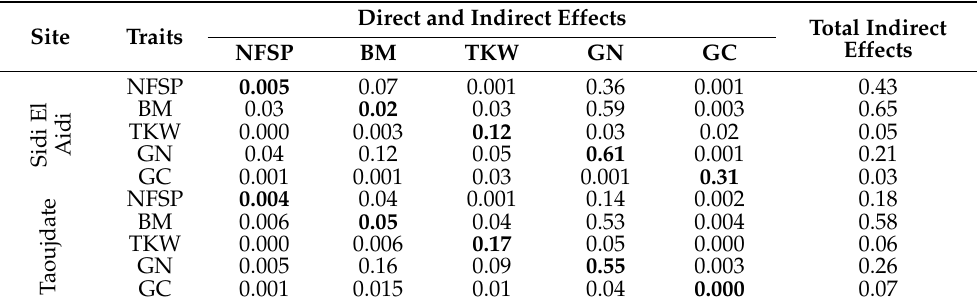
Table 3. Direct and indirect effects of each variable on grain yield under favorable and dry environments. Site